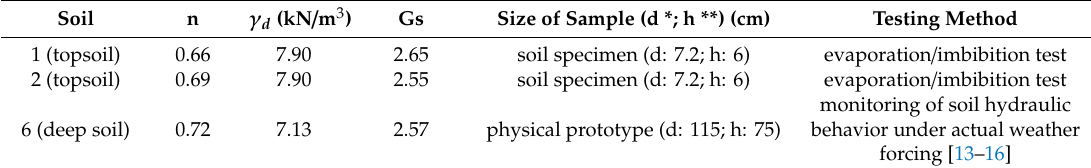
Table 1. Mean physical properties of tested soils, sample sizes, and adopted methods.